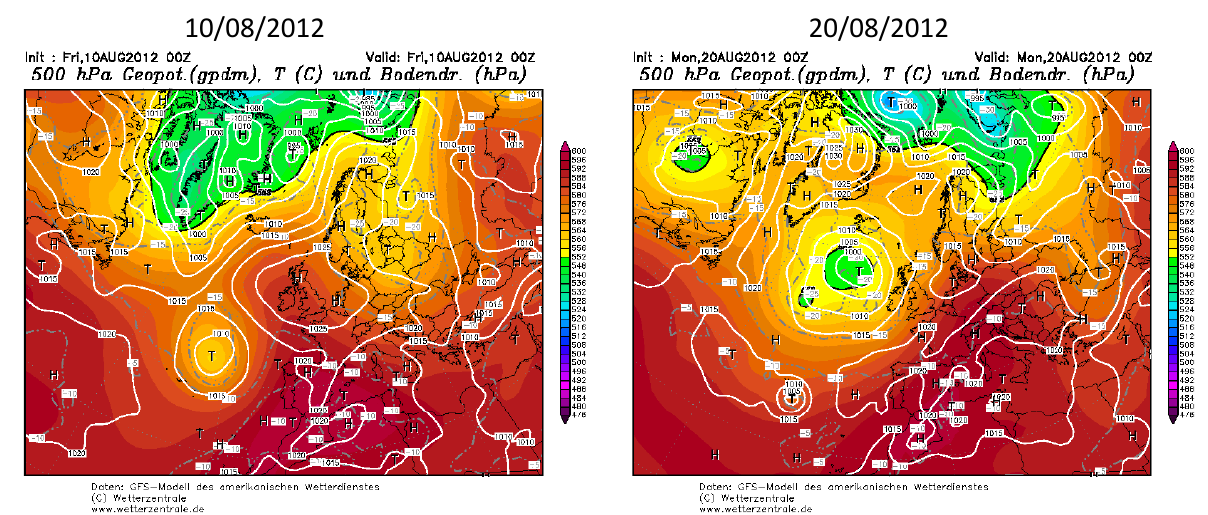
Figure 5. Wind roses of 222 Rn concentration (hourly values) during the sampling period at Bilbao and Vitoria.